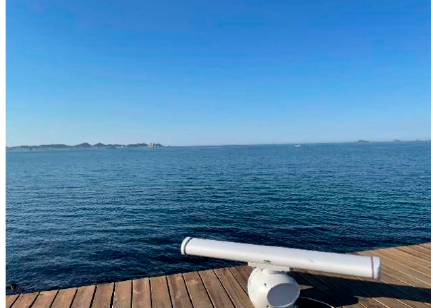
Figure 1. Measured sea area and radar in Bohai Sea.